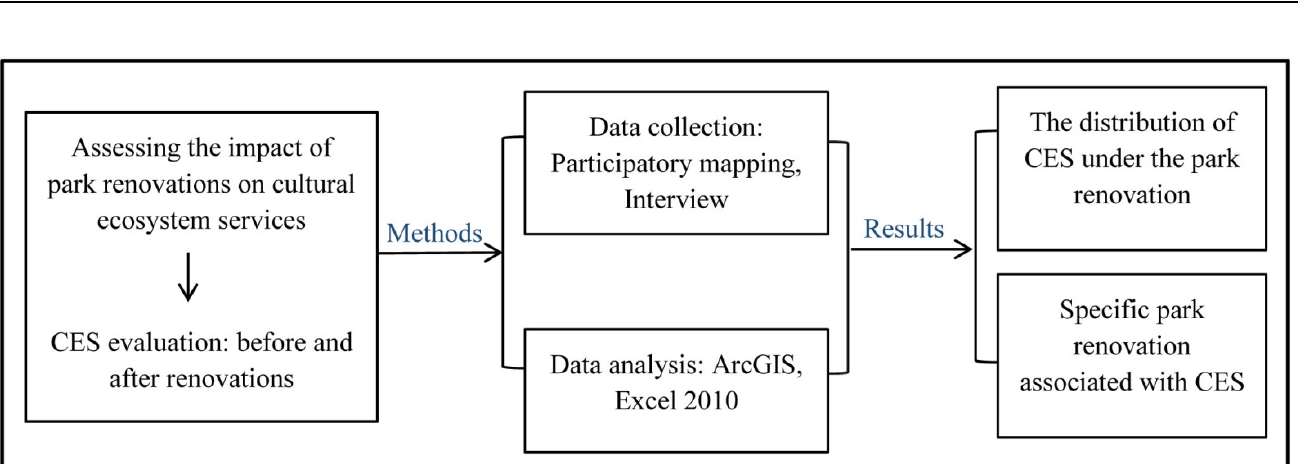
Figure 2. The framework of this study.